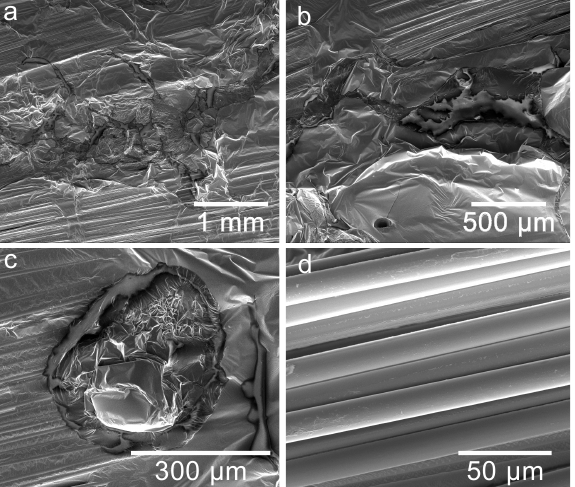
Figure 5. Scanning electron microscopy (SEM) micrographs of coated uncured prepreg layers. On the prepreg surface, fiber-rich and resin-rich areas can be observed. Especially the epoxy-rich areas show a high degree of surface roughness (see ( a )). Outgassing of voids and bubbles contained in the epoxy can cause perforations of the epoxy (see ( b )). Craters of different dimensions can also be observed on the surface (see ( c )). The individual fibers, exposed at the surface of the prepreg are shown. On the fibers itself, the roughness is less pronounced (see ( d